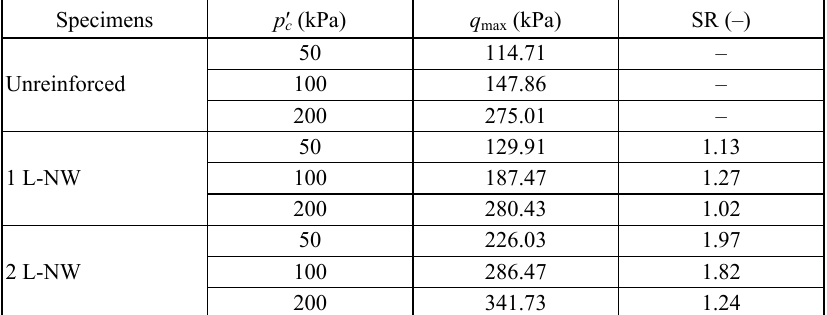
Table 5. Maximum deviator stress and strength ratio values of experimental program Specimens